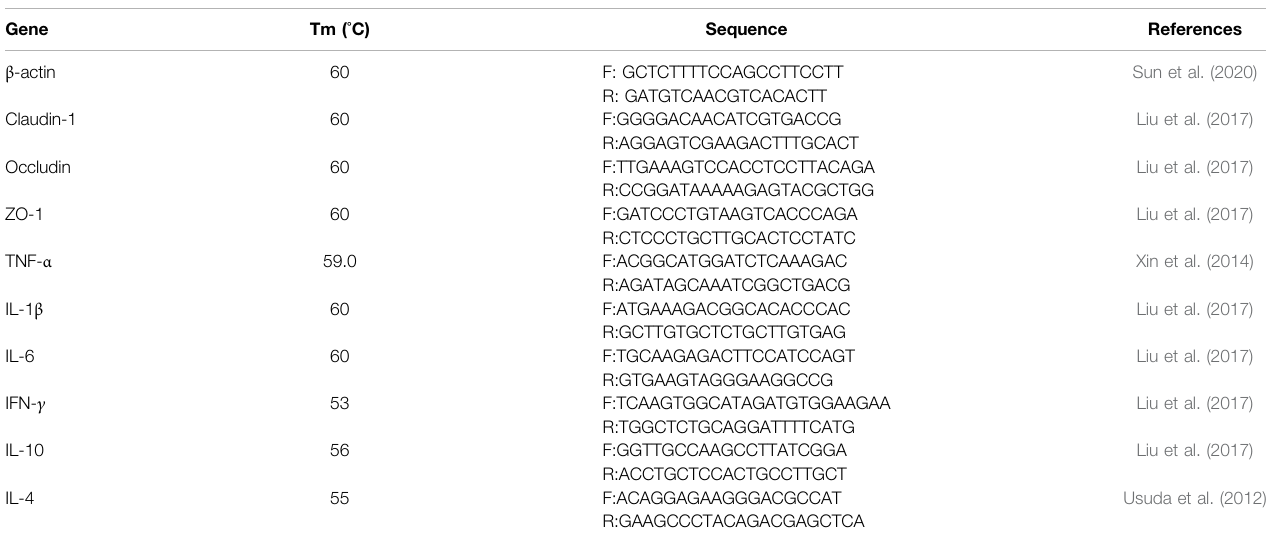
TABLE 2 | Primer sequences for RT-qPCR in small